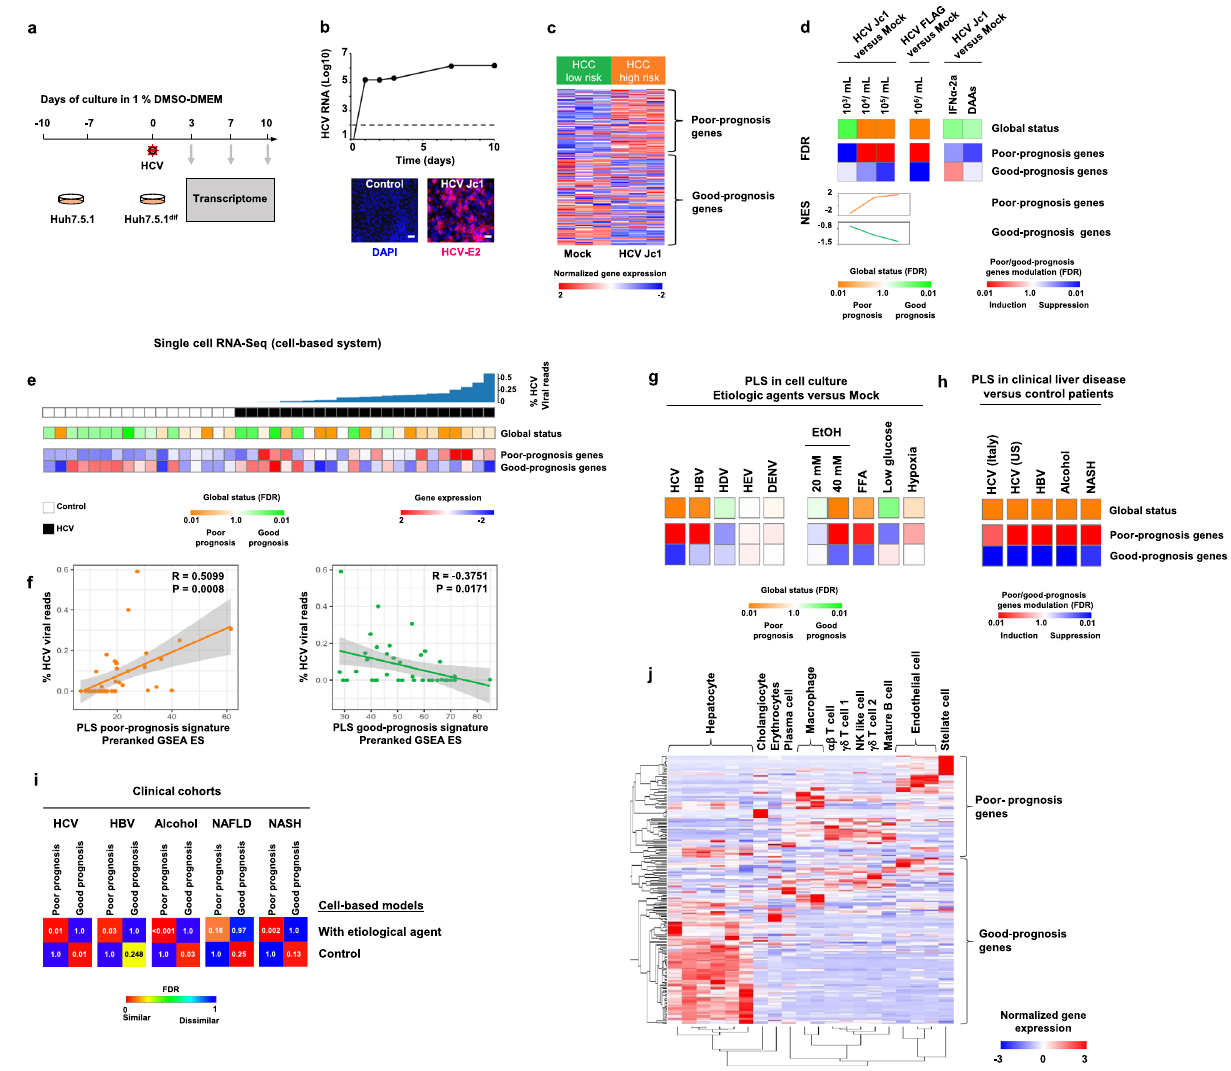
(log10 of relative RNA quantity normalized to GAPDH mRNA; mean ± SD, n = 3). Immunodetection of HCV E2 protein 10 days post infection. Scale